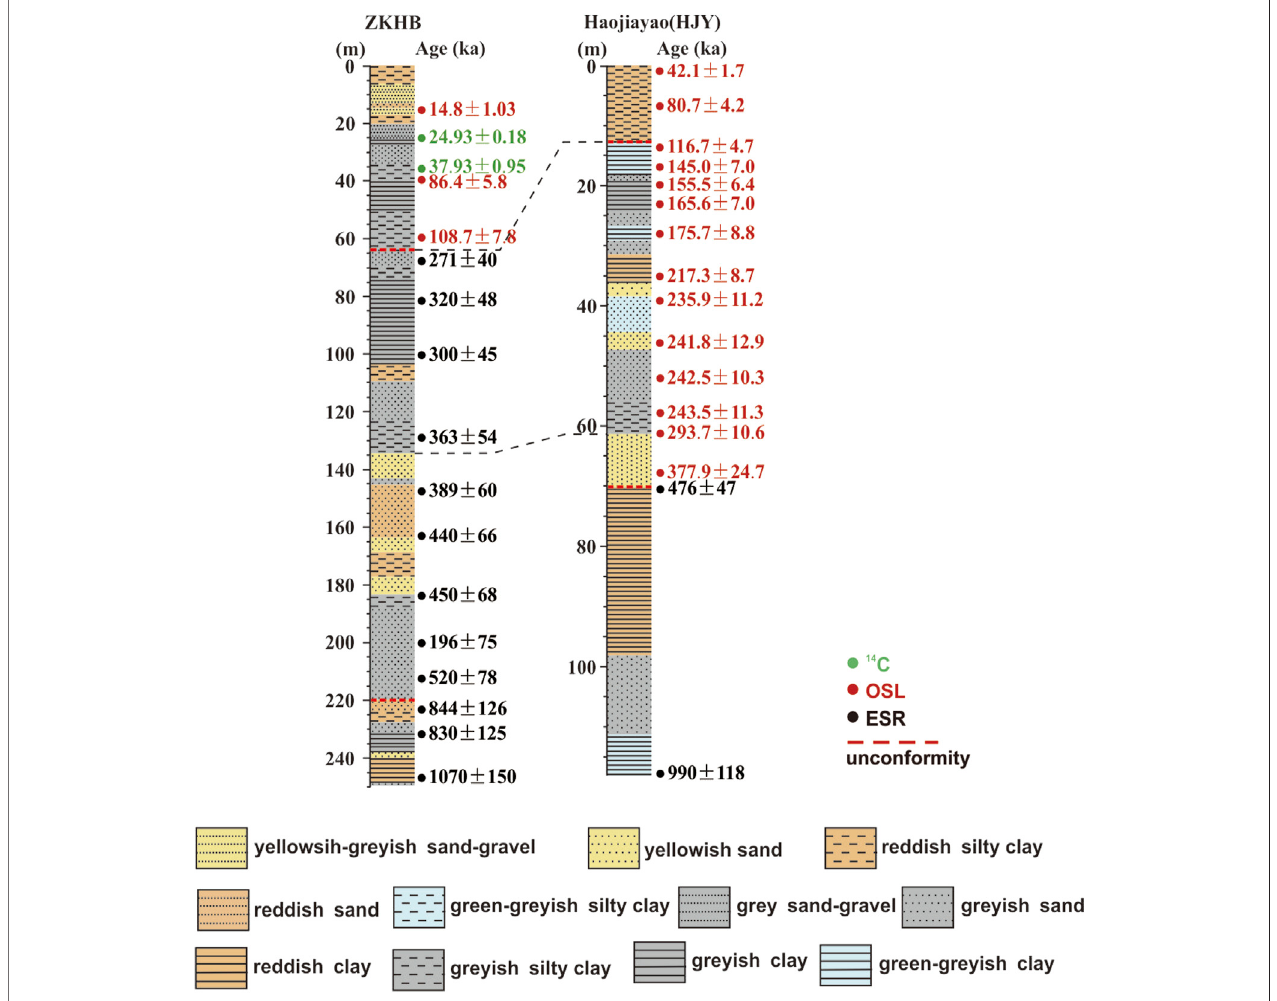
FIGURE6| CorrelationsoftwodrillingcoresintheHetaoBasinbasedonthelithologyanddatingages.Boreholelocationsareshownin Figure2 .Thelithologyand ages for these cores are from Jianbiao Li et al. (2007) (ZKHB) and Jiang et al. (2013) (HJY).